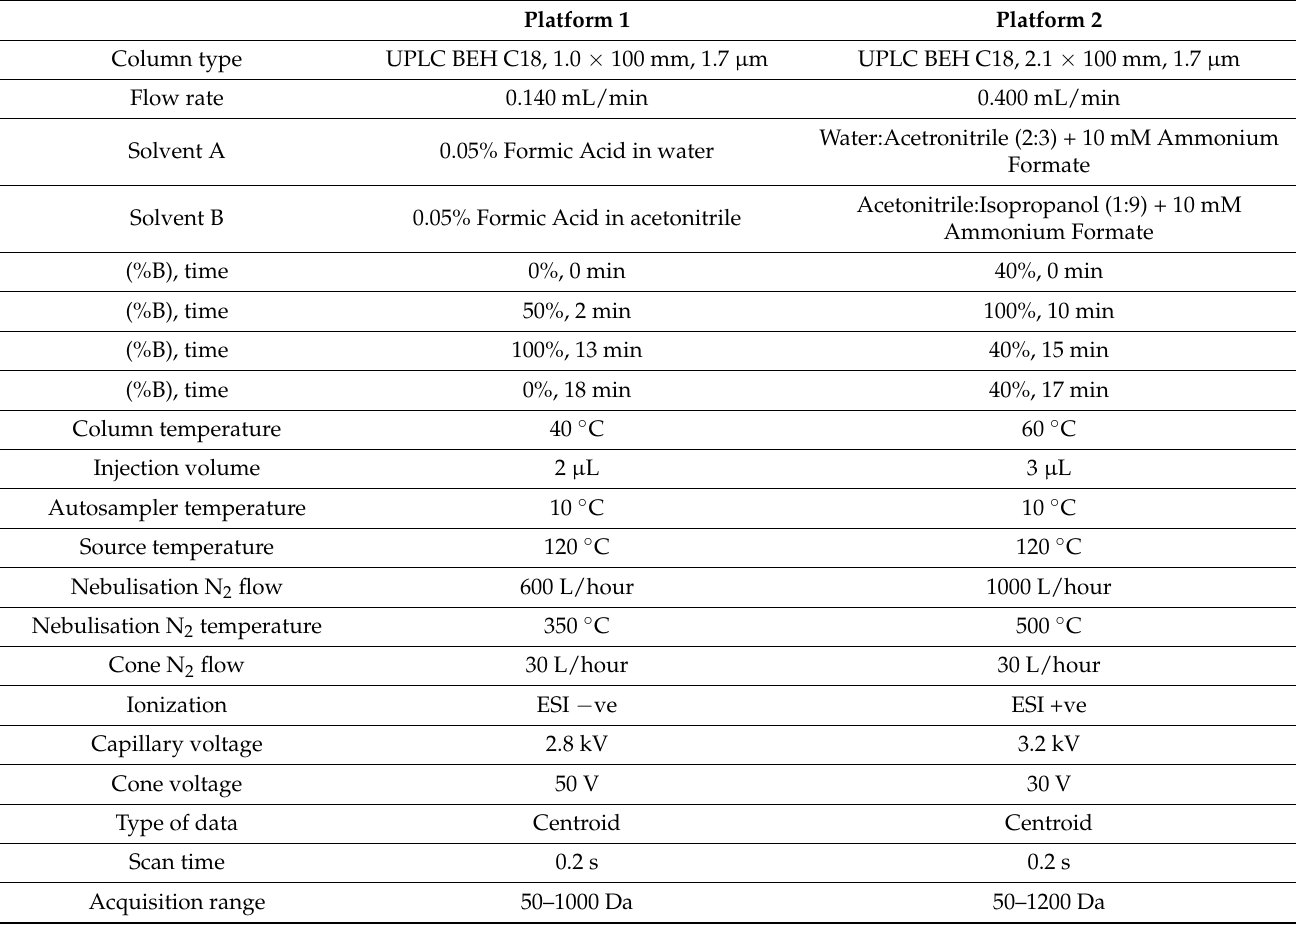
Table 1. Chromatographic and mass-spectrometric workflows used in this study. Platform